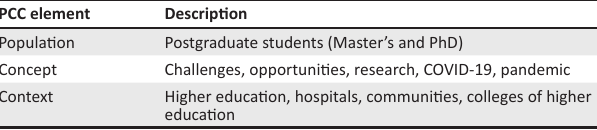
TABLE 1: Population, concept and context